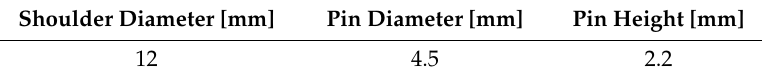
Table 3. The FSW tool dimension for experiments.